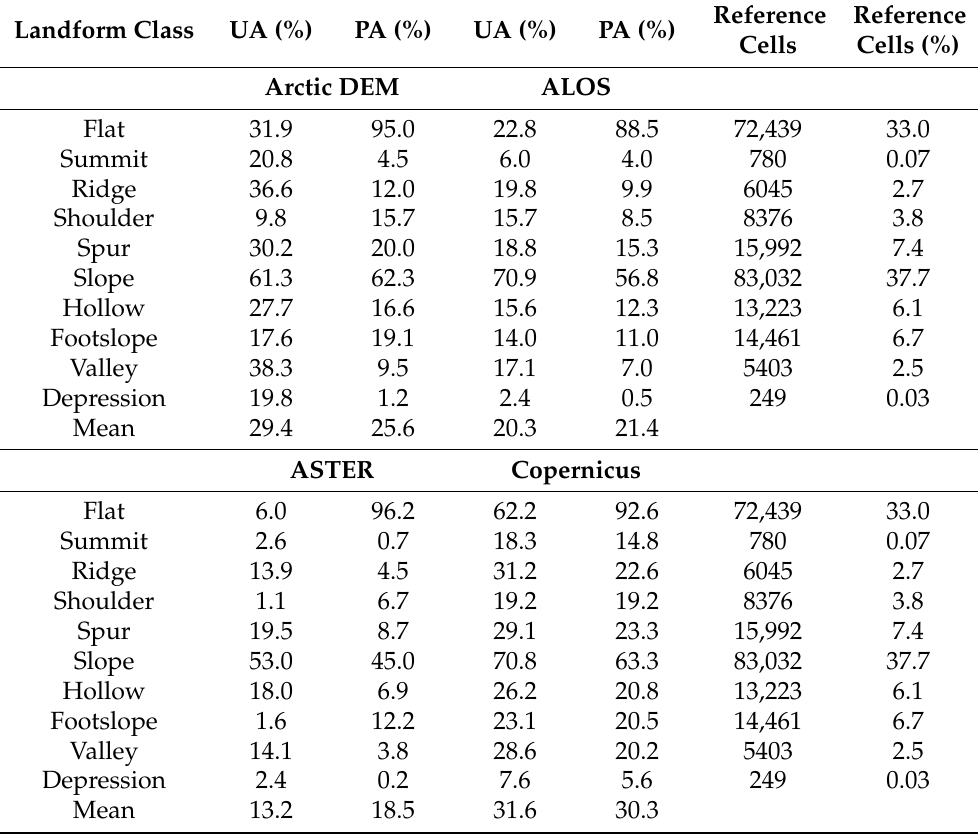
Table 8. User and producer accuracy for ten landform classes derived for candidate